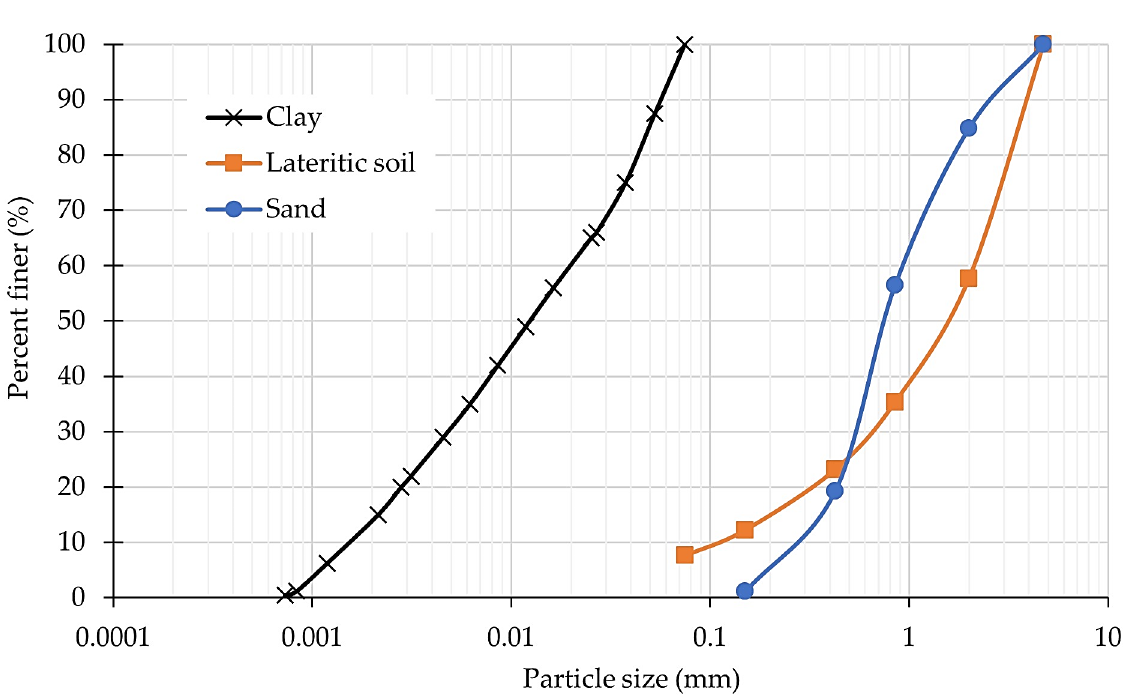
Figure 1. Soil samples: ( a ) clay; ( b ) lateritic soil; ( c ) sand.